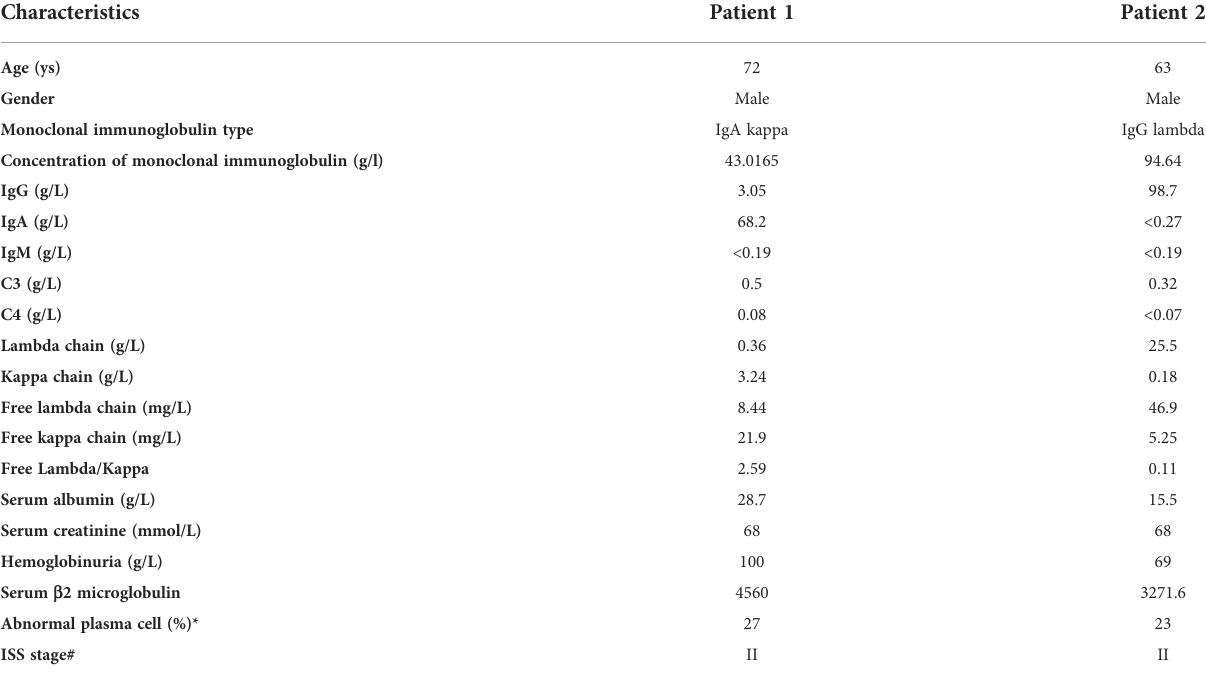
TABLE 1 Baseline characteristics of patients with multiple myeloma included in the study.